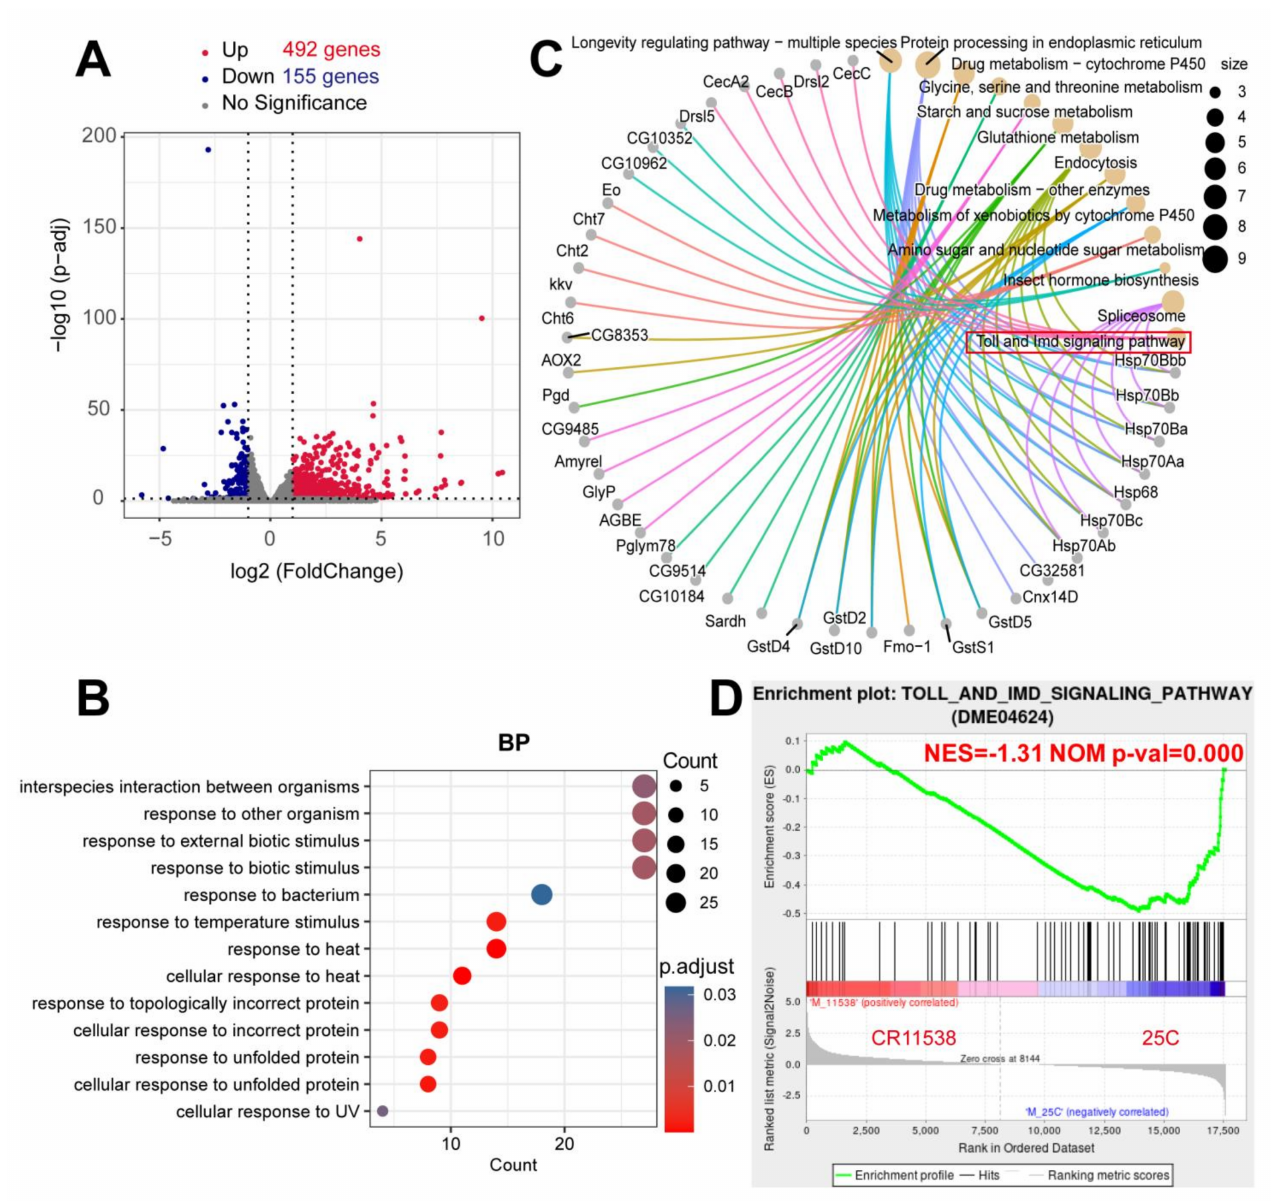
Figure 2. Enrichment analysis of DEGs in the CR11538-overexpressing flies after stimulation with M. luteus . ( A ) Volcano map showing DEGs among Gal80 ts ; Tub> CR11538 and Gal80 ts ; Tub-Gal4/P{CaryP}attP40 after M. luteus challenge. Red: upregulated genes (>2-fold difference in relative expression and adjusted p < 0.05); blue: downregulated genes (< − 2-fold difference in relative expression and adjusted p < 0.05). ( B ) Biological process enrichment analysis results were obtained using all DEGs. ( C ) Network diagram showing pathways and corresponding genes in KEGG pathway enriched with all DEGs. “size” represents the number of differentially expressed genes (DEGs) contained in each pathway. ( D ) GSEA analysis on the RNA-seq data between the CR11538 -overexpressing flies and the control. The GSEA diagram is divided into three parts. The first part is the line graph of gene Enrichment Score. The second part uses lines to mark the genes under the gene set. The third part is the rank value distribution map of all